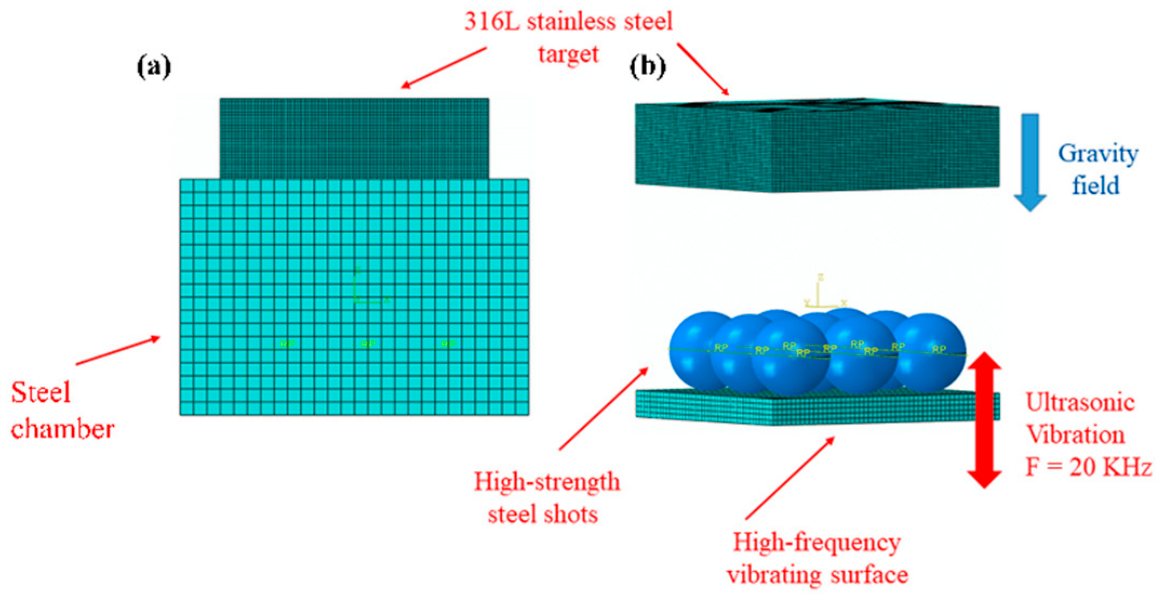
Figure 12. Finite element simulation model for ultrasonic shot peening process with multiple steel shots: ( a ) entire meshed simulation model; ( b ) view of established FE model without steel chamber.